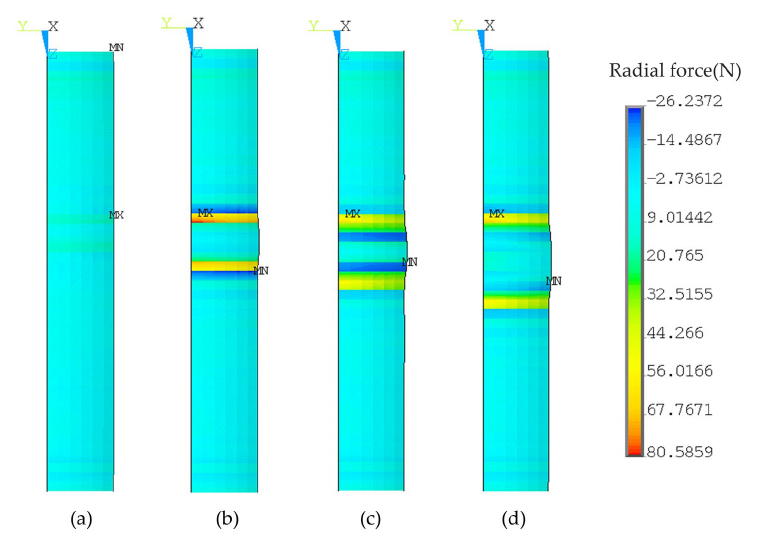
Figure 15. Effects of groove width on radial force at groove edge. ( a ) 2 mm; ( b ) 4 mm; ( c ) 6 mm; ( d ) 8 mm.